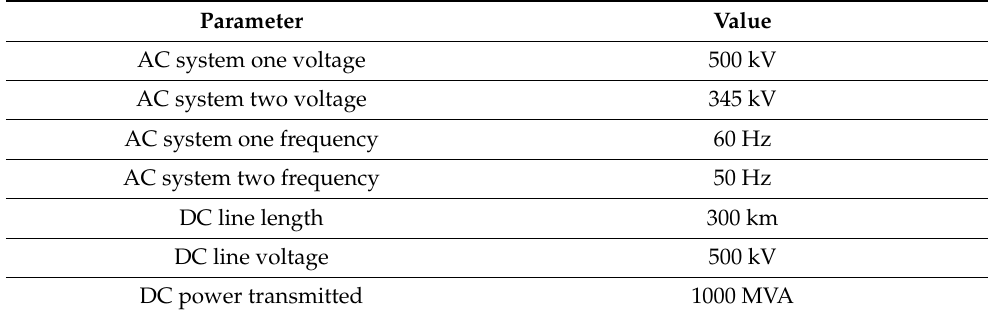
Figure 2. LCC - HVDC system under study. Figure 2. LCC-HVDC system under study. Table 1. Parameters of the HVDC system under study. Table 1. Parameters of the HVDC system under